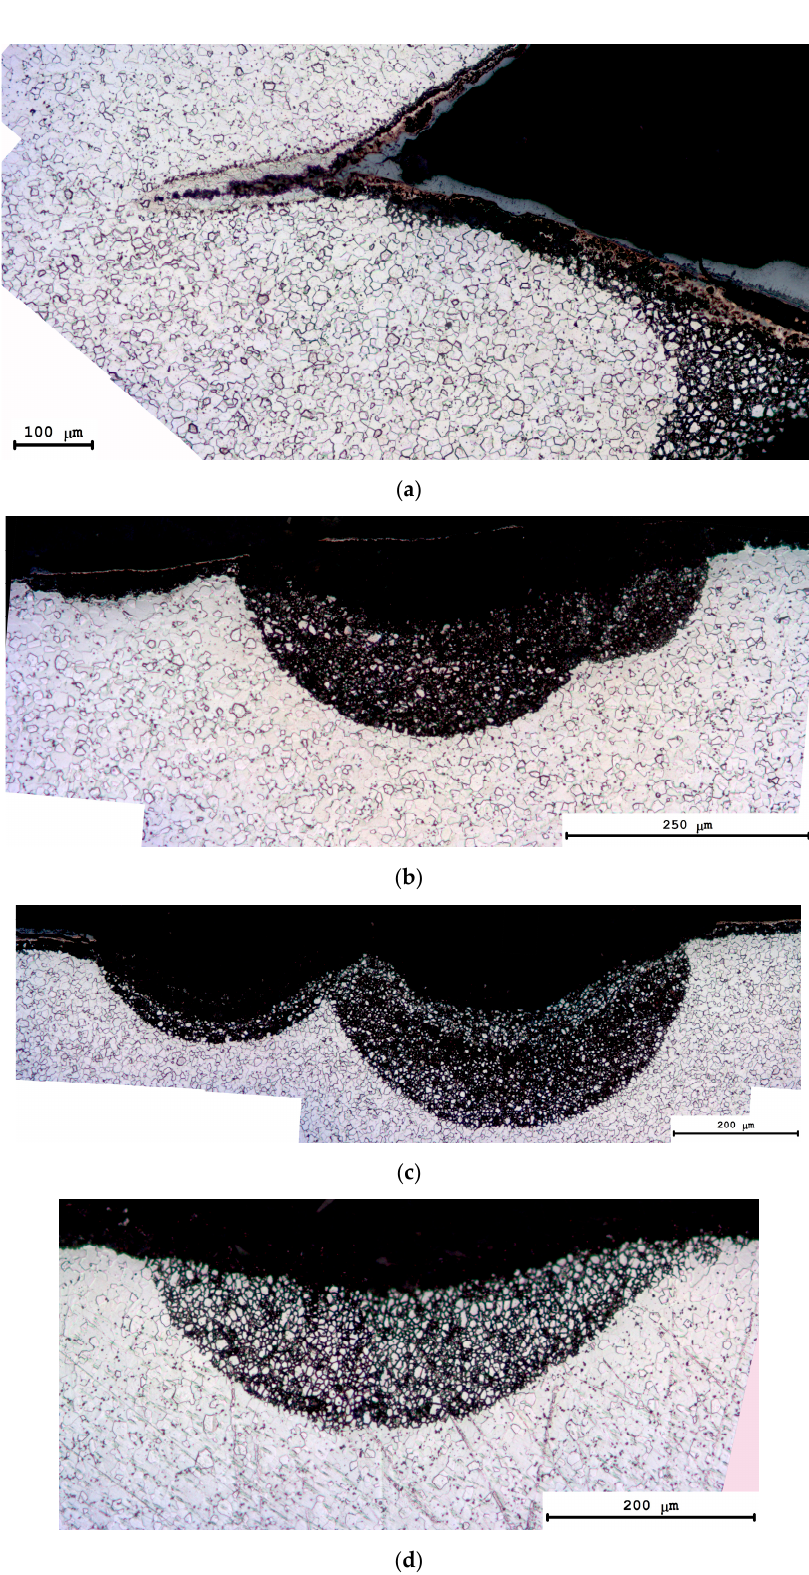
Figure 15. Corrosion defects on the surface of the UFG specimens after HSC testing: ( a ) V h = 100 ◦ C/min, T = 700 ◦ C, t = 0 min, P = 50 MPa, ( b ) V h = 100 ◦ C/min, T = 600 ◦ C, t = 10 min, P = 50 MPa, ( c ) V h = 100 ◦ C/min, t = 800 ◦ C, t = 10 min, P = 50 MPa, ( d ) V